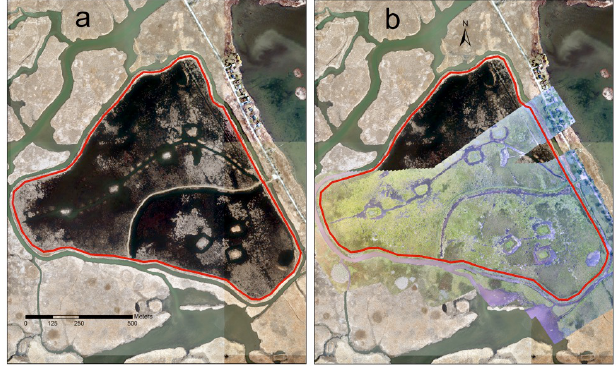
Figure 2: a) Photo of the 2010 SWOOP image alone. b) Photo showing the UAV-acquired mosaic image on top of the 2010 SWOOP image. The red line indicates the boundary of the